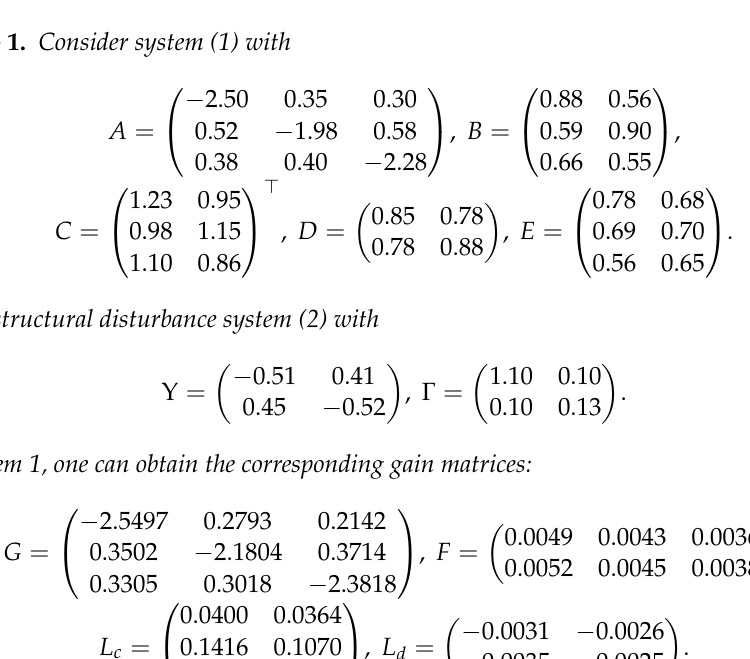
Figure 1. The virtual